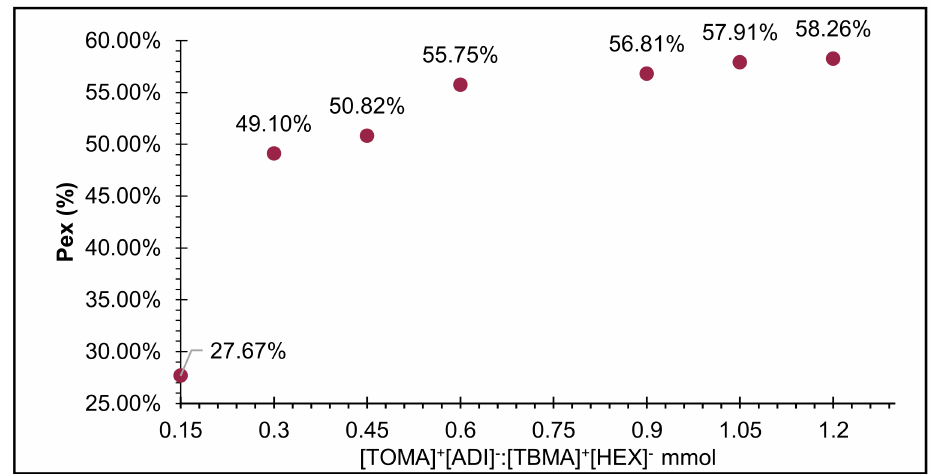
Figure 2. Average results of extraction percentage (P ex ) of CBE by different systems. Based on qualitative and quantitative extraction tests of a commercial pigment (CBE), the best results were shown by the cation [TOMA] + , and this effect could be attributed to the increasing number of aliphatic chains, which confirmed the statement that, in general, the physical properties of ILs are given to a greater extent by the cationic part [21]. The ILs [THMA] + [ADI] − and [THMA] + [FUM] − had similar performance; however, the [TOMA] + structure in the cationic part, particularly [TOMA] + [ADI] − , reached 68.90% for the commer- cial pigment. The best extraction system, formed by [TOMA] + [ADI] − /[TBMA] + [HEX] − , was used to extract betanin directly from fresh beet juice, where the concentration (309 ppm) of natural pigment was around 3 times greater than the concentration of the commercial product in the same volume (3 mL) (Figure 3).